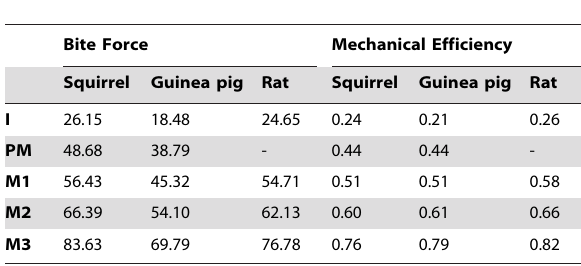
Table 1. Average predicted bite force (N) and mechanical efficiency of biting at each